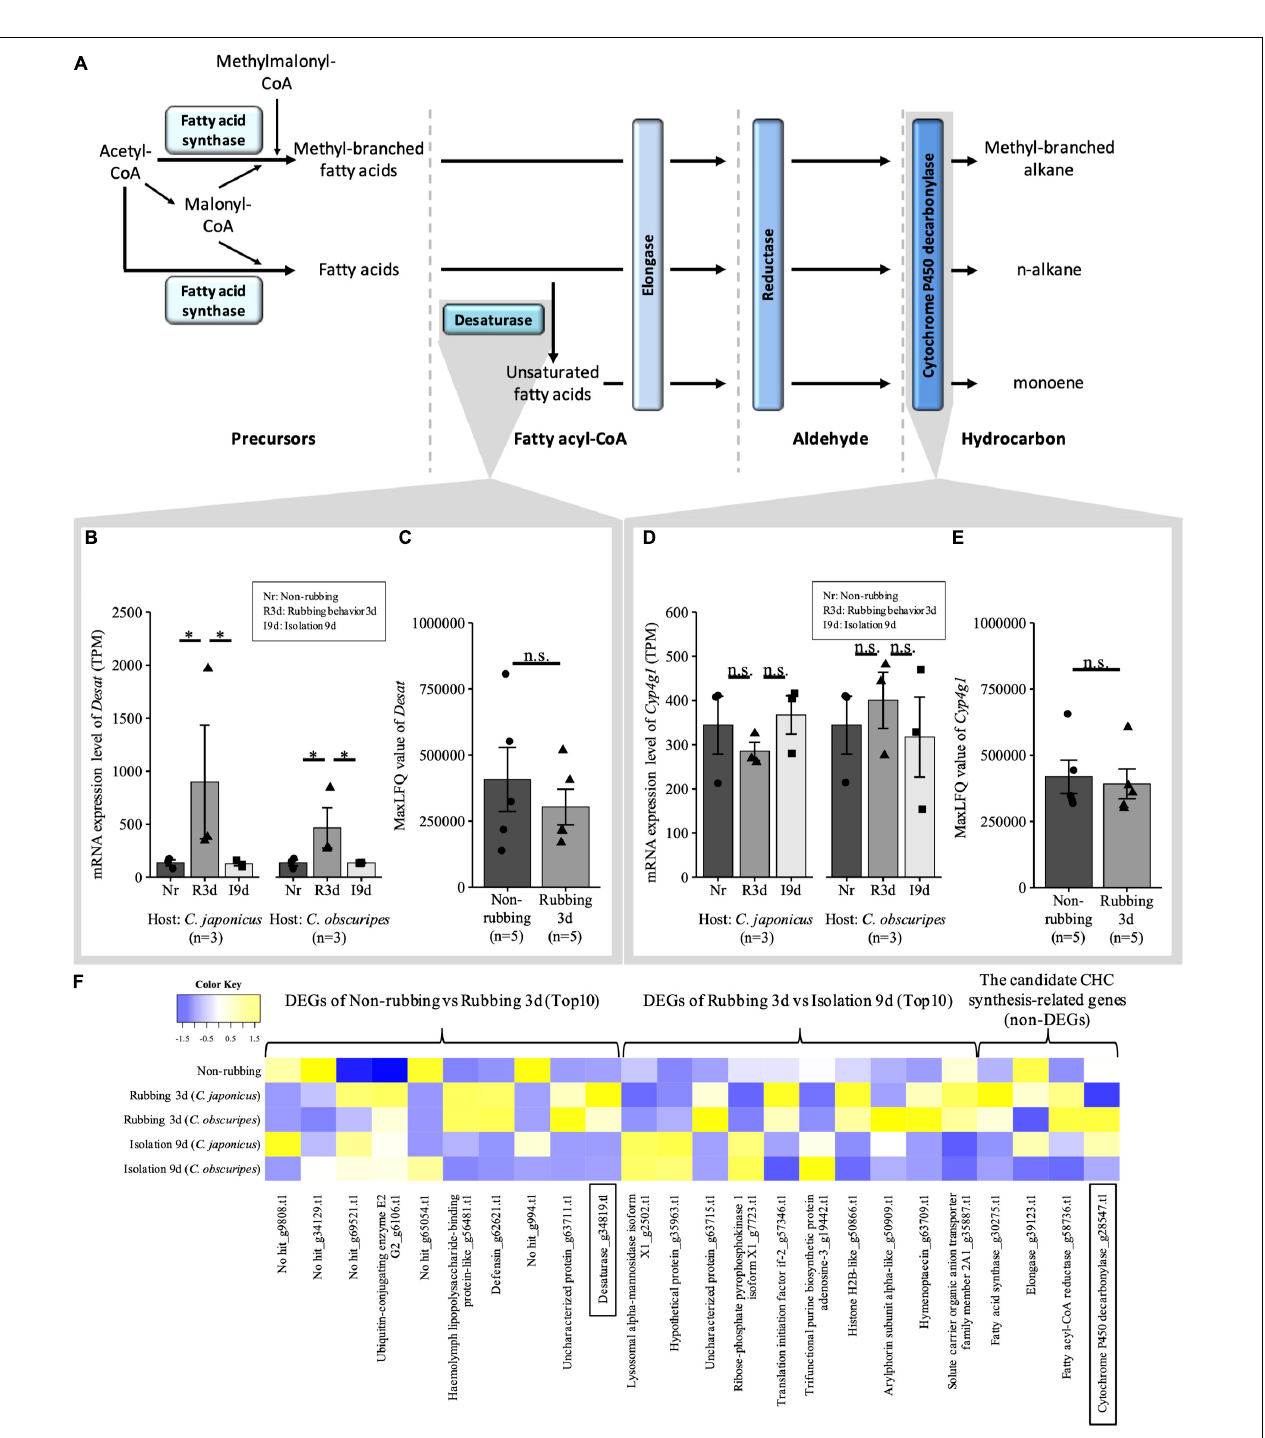
FIGURE 4 | The expression levels of CHC synthesis-related genes in the whole abdomen. (A) The synthesis pathway of CHC (modified from Chung and Carroll, 2015). (B,D) The expression levels of desaturase ( Desat ): g34819.t1 in mRNA from the whole abdomen by transcriptome (B) and protein from fat body by quantitative analysis of key proteins using LC-MS analysis (C) . The expression levels of cytochrome P450 decarbonylase ( Cyp4g1 ): g28547.t1 in mRNA from the whole abdomen by transcriptome (D) and protein from fat body by quantitative analysis of key proteins using LC-MS analysis (E) . In mRNA; *, significant difference: FDR < 0.05 (the actual value: 0.000–0.008); n.s., non-significant difference (the actual value: 1.000), n = 3. In protein, one-way ANOVA; n.s., non-significant difference (the actual value: 0.473–0.758), n = 5. (F) The heatmap of expression levels of the top ten differentially expressed genes (DEGs) and the top-hit